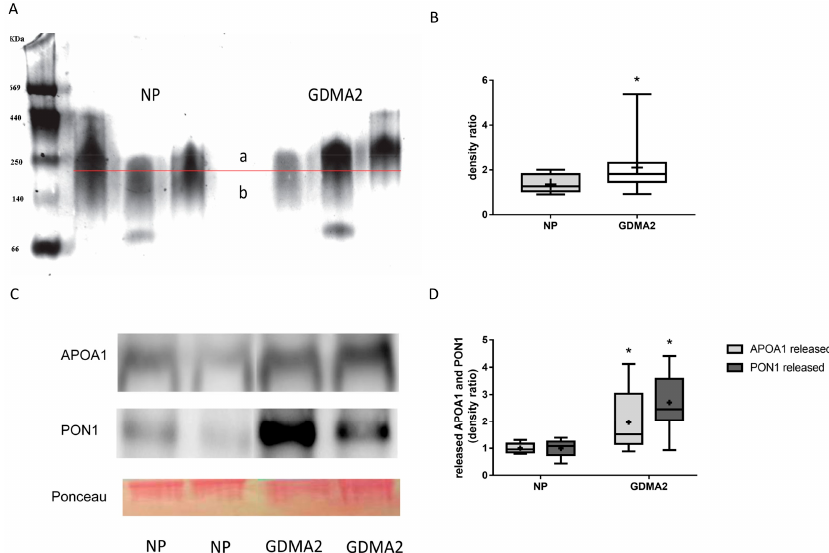
Figure 1. HDL composition: APOA1 and PON1 expression. ( A ) HDL from normal pregnancy (NP) (control) and GDMA2 were separated from plasma and run on native 4–12% PAGE. Band intensities above (a) and below (b) the horizontal lines drawn in the middle of each control HDL band were analyzed. ( B ) The ratio a / b was calculated for GDMA2 HDL as compared to the NP HDL (box plot